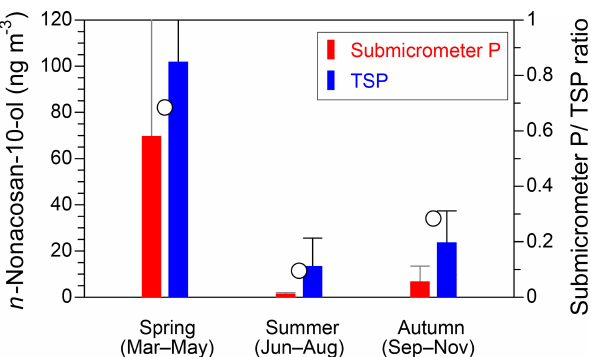
Figure 5. Seasonal averages of the mass concentrations of n - nonacosan-10-ol in the submicrometer particles (P) (red) and TSP (blue) samples obtained at the TMK site. The error bars show the standard deviations, and open circles indicate the mass ratios of the submicrometer P /